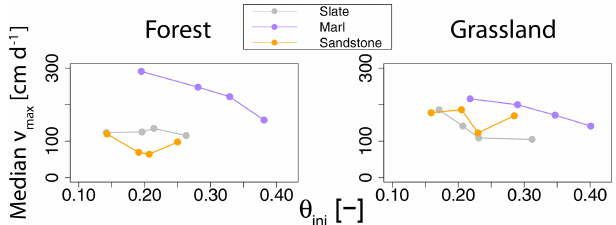
Figure 11. Relationship of median v max with θ ini for each land- scape unit. Each point represents median v max for all events which fall in the four different quartiles of initial soil moisture (the plot- ting position of θ ini value represents a quartile median). Number of events observed in the different classes can be found in the Supple- ment (Table